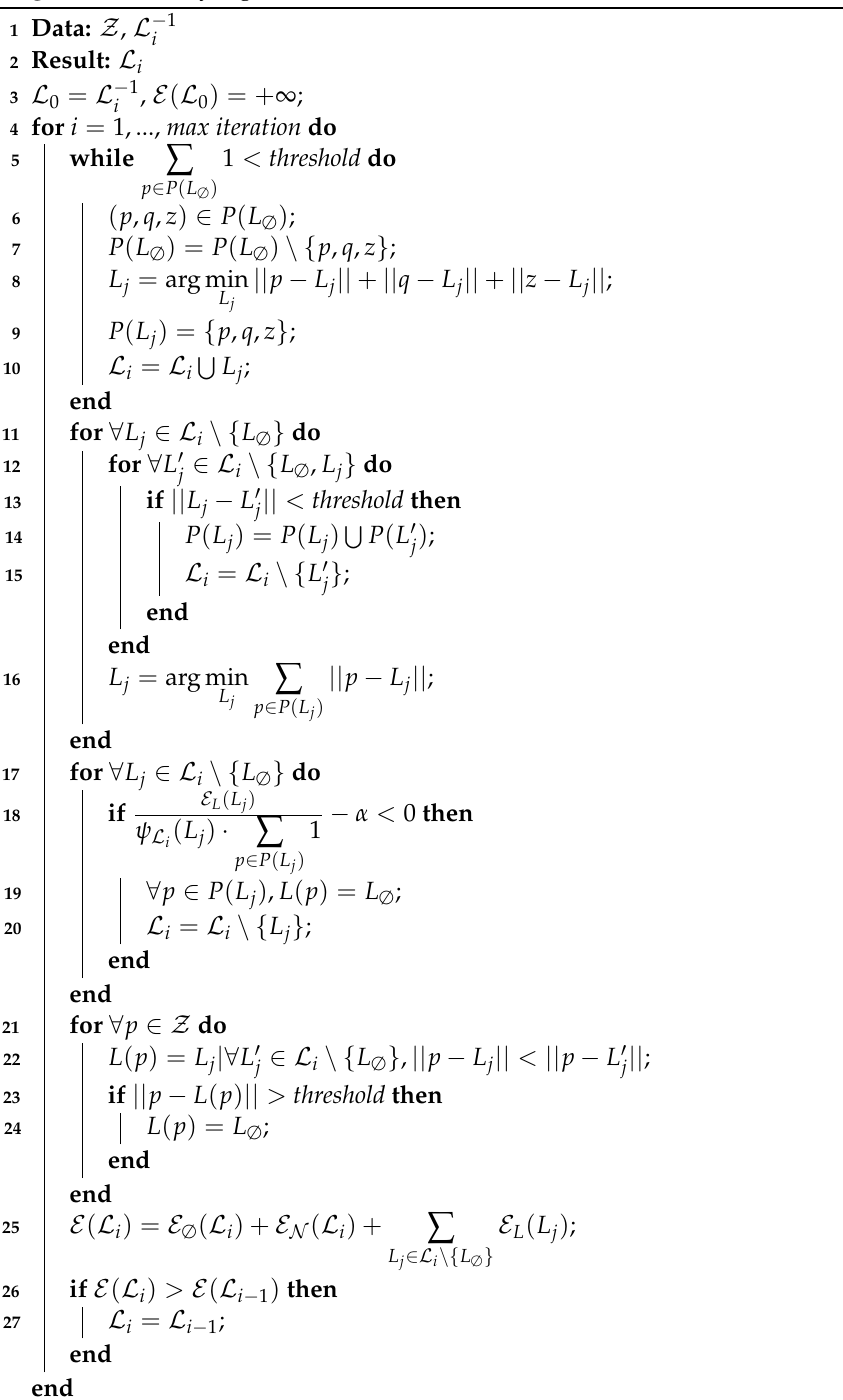
Algorithm 1: Ruby